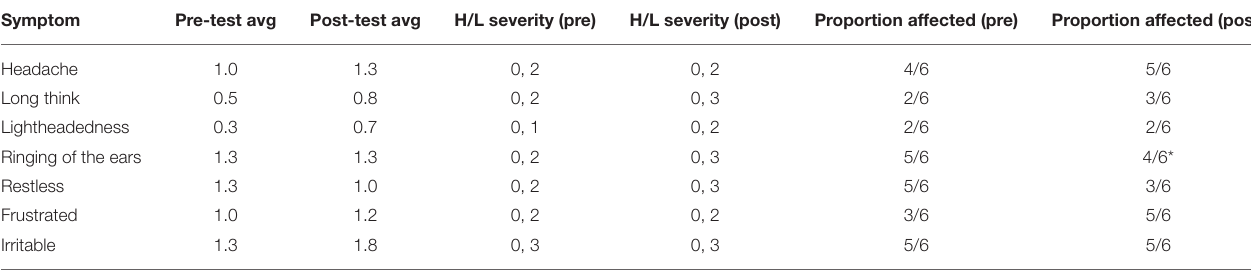
TABLE 1 | Analysis of symptom reporting and